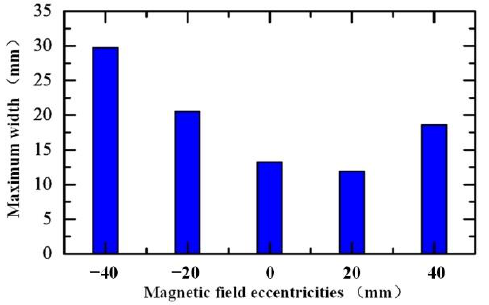
Figure 30. Scratch damage maximum width with different magnetic field eccentricities.